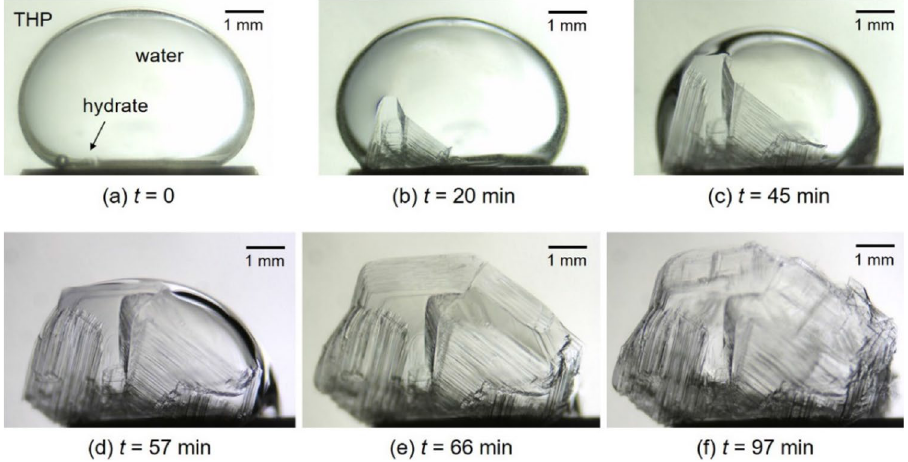
Figure 1. Sequential images of H 2 + CO 2 + THP hydrate growing on a water droplet at T ex = 284.2 K, Δ T sub = 1.3 K, P = 5.00 MPa. The gas composition was H 2 :CO 2 = 0.55:0.45 in mole fraction. The elapsed time after the hydrate nucleation is indicated below each